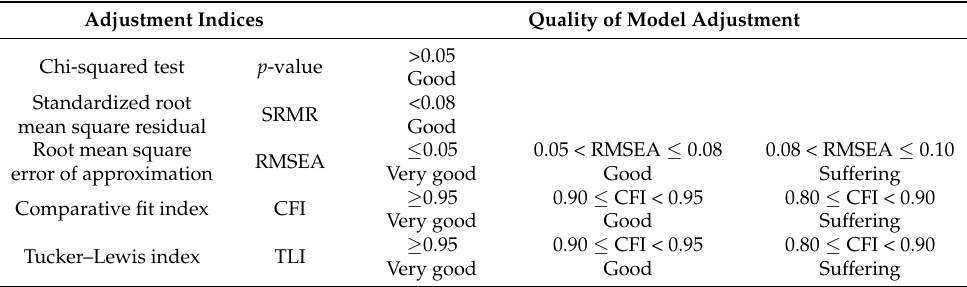
Table 2. Global measures of scale